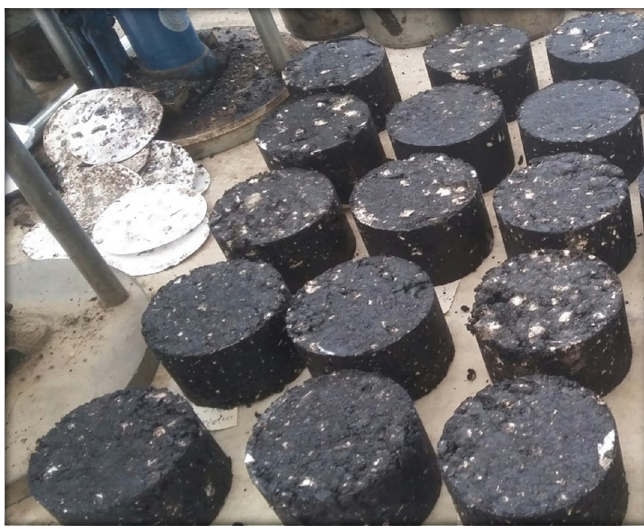
Figure 3. Three Marshall Samples for each mix.